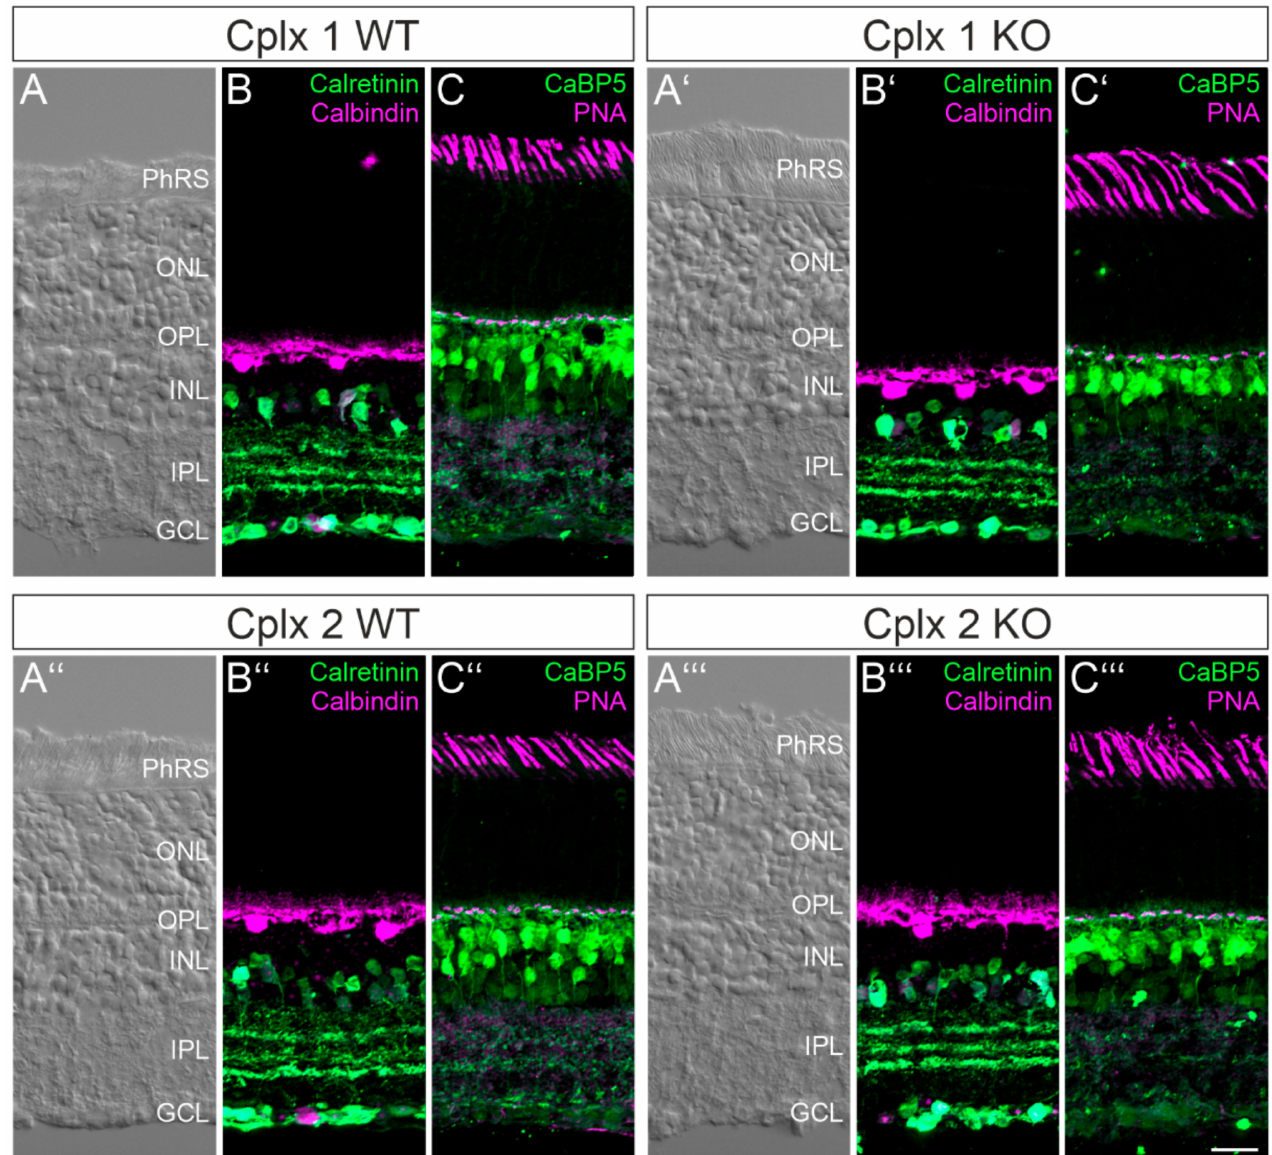
Figure 3. Comparison of the retinal structure between wildtype (WT) and Cplx 1 and Cplx 2 knockout (KO) mice. ( A – A (cid:48)(cid:48)(cid:48) ) Nomarski micrographs of vertical cryostat sections through the retinae of WT and Cplx 1 and Cplx 2 KO mice. ( B – B (cid:48)(cid:48)(cid:48) ) Fluorescence micrographs of vertical cryostat sections through the retinae of WT and Cplx 1 and Cplx 2 KO mice double labeled for amacrine and ganglion cells (anti-calretinin) and horizontal cells (anti-calbindin). ( C – C (cid:48)(cid:48)(cid:48) ) Fluorescence micrographs of vertical cryostat sections through the retinae of WT and Cplx 1 and Cplx 2 KO mice double labeled for bipolar cells (anti-CaBP5) and cone photoreceptors (PNA). PhRS, photoreceptor segments; ONL, outer nuclear layer; OPL, outer plexiform layer; INL, inner nuclear layer; IPL, inner plexiform layer; GCL, ganglion cell layer. Scale bar = 20 µ m in ( C (cid:48)(cid:48)(cid:48) ) for ( A – C (cid:48)(cid:48)(cid:48)